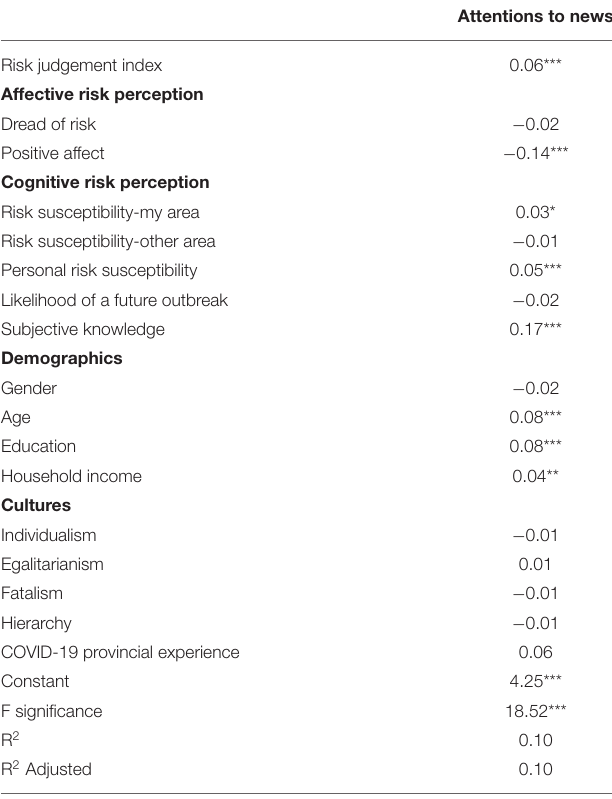
TABLE 6 | Linear regressions of attention to news and survey of public reactions to COVID-19, China, 2020.